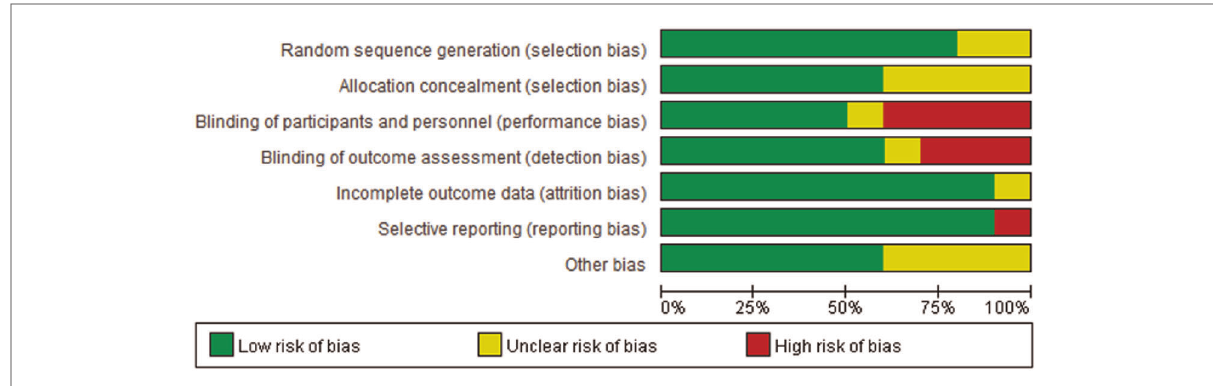
FIGURE 3 Risk-of-bias summary for each included study. Green (+), red ( – ), and yellow (?) circles indicate low, high, and unclear risk of bias, respectively.